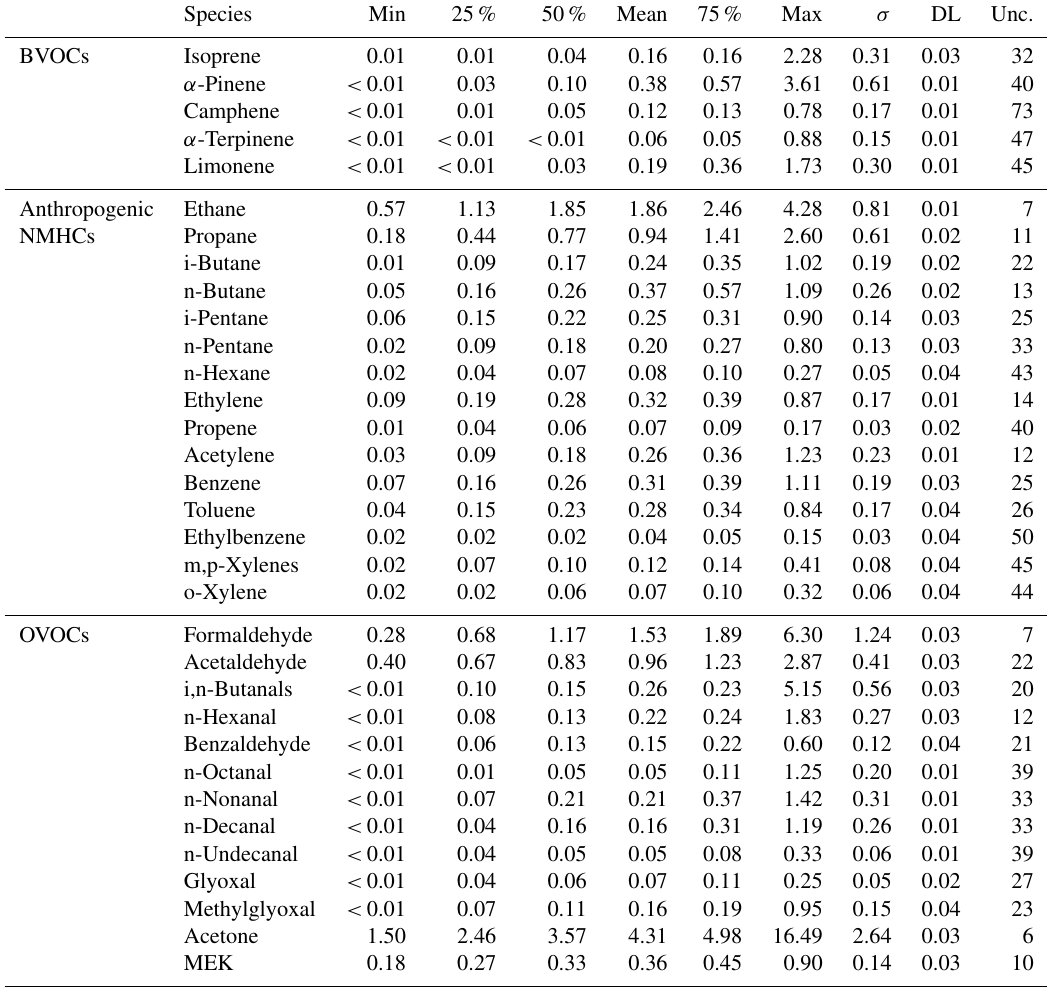
Table 3. Statistics (µgm − 3 ), standard deviations ( σ – µgm − 3 ), detection limits (DL – µgm − 3 ) and relative uncertainties (Unc. – %) of selected VOC concentrations measured at the site from June 2012 to June